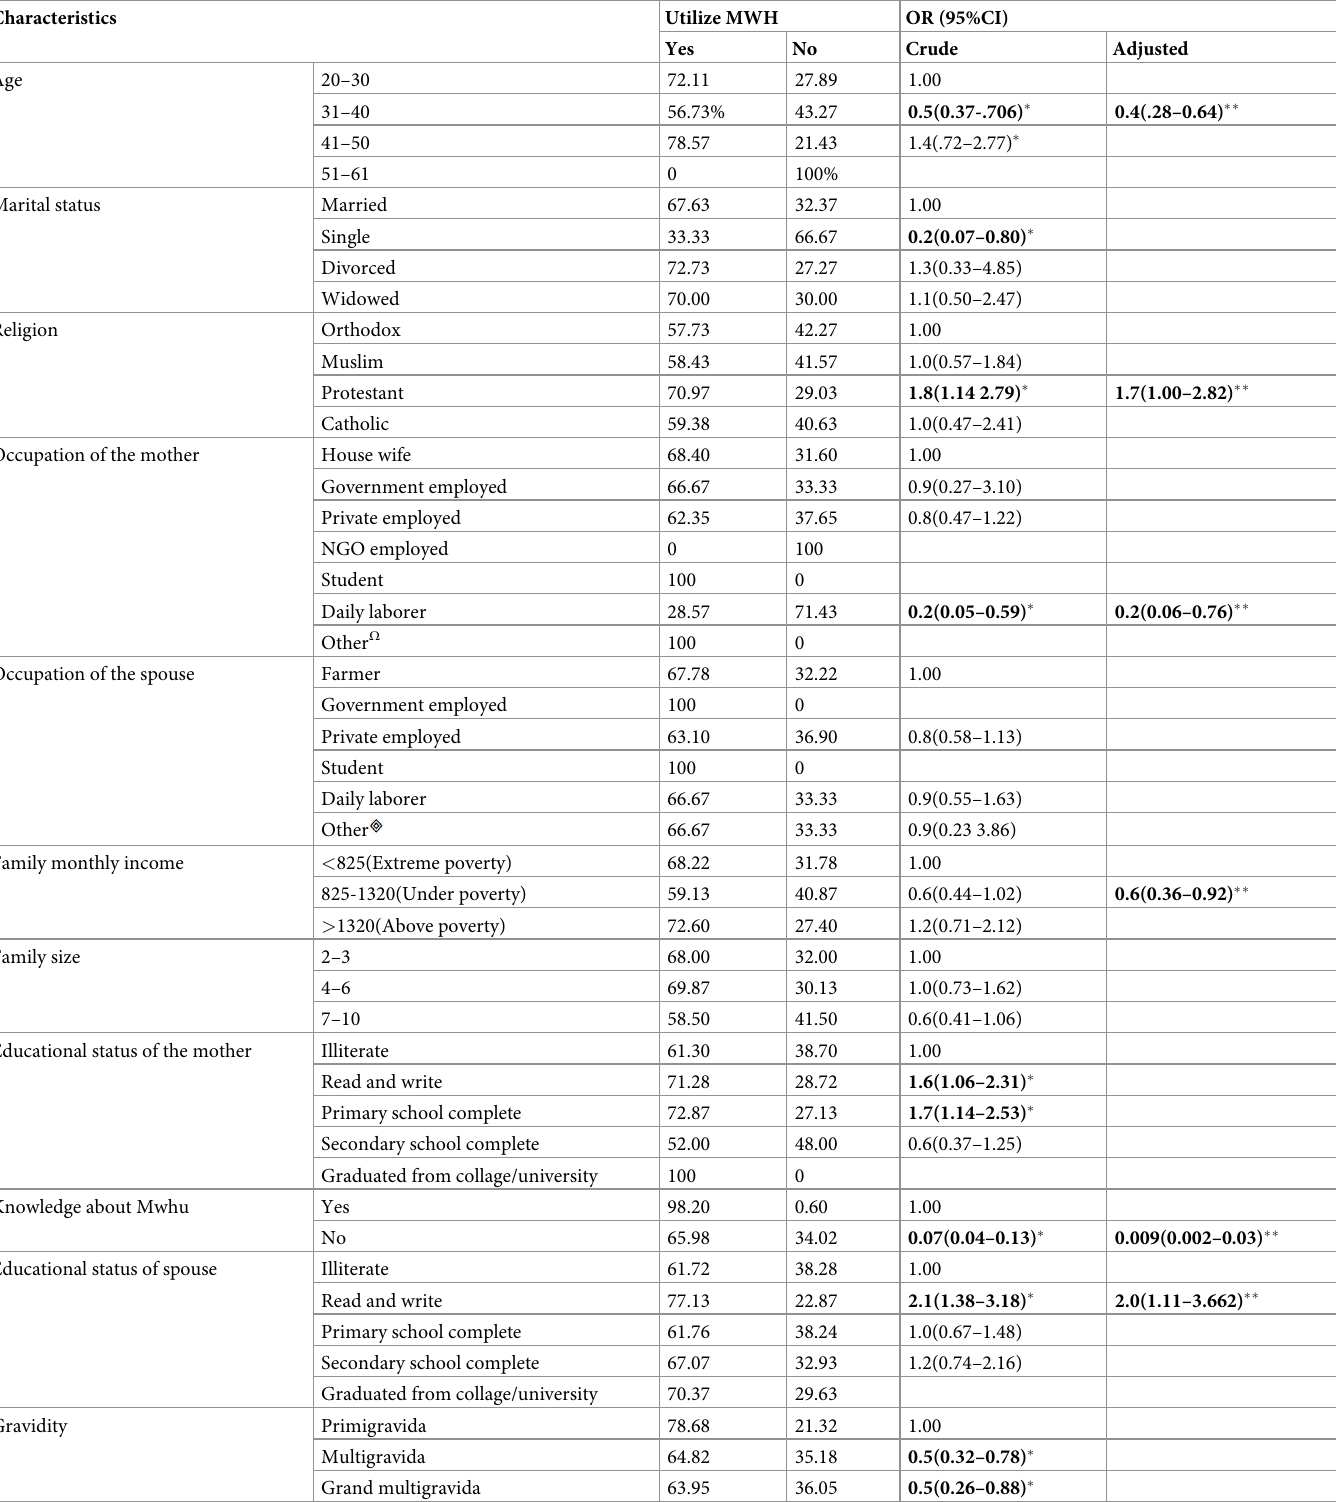
Table 2. Logistic regression analysis results of participants for maternity waiting home utilization in Sidama Zone, southern Ethiopia, April/2019 (n = 745).